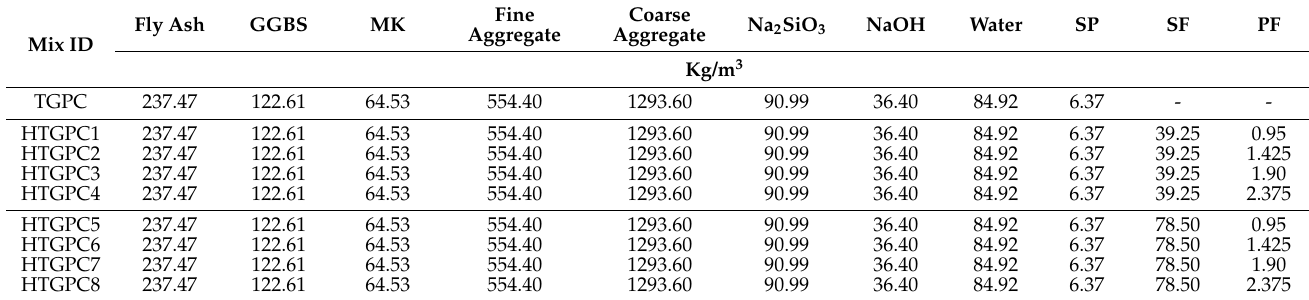
Table 1. Mix proportions of HTGPC